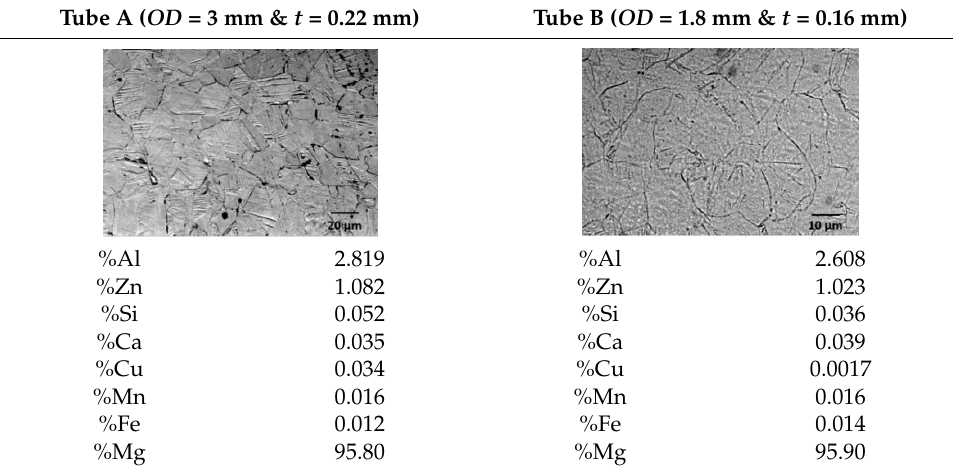
Table 2. Microstructure and chemical composition of magnesium miniature tubes.